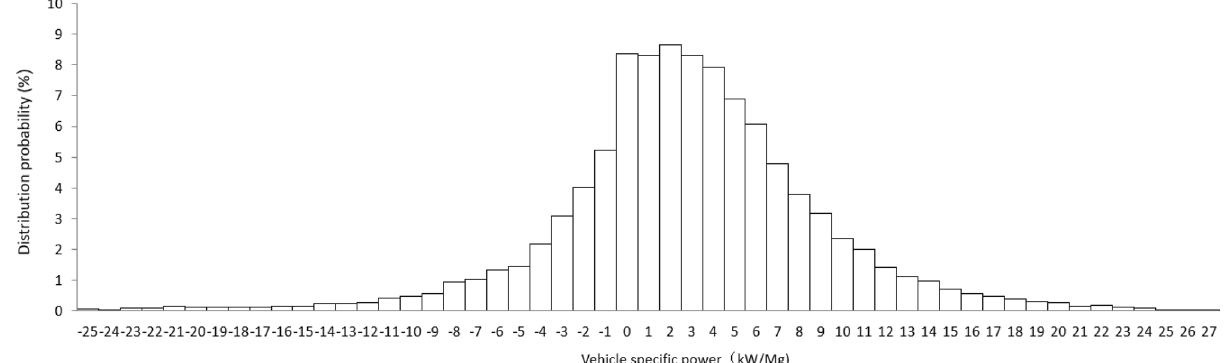
Figure 2. VSP distribution probability of light gasoline vehicles in Beijing. No. of